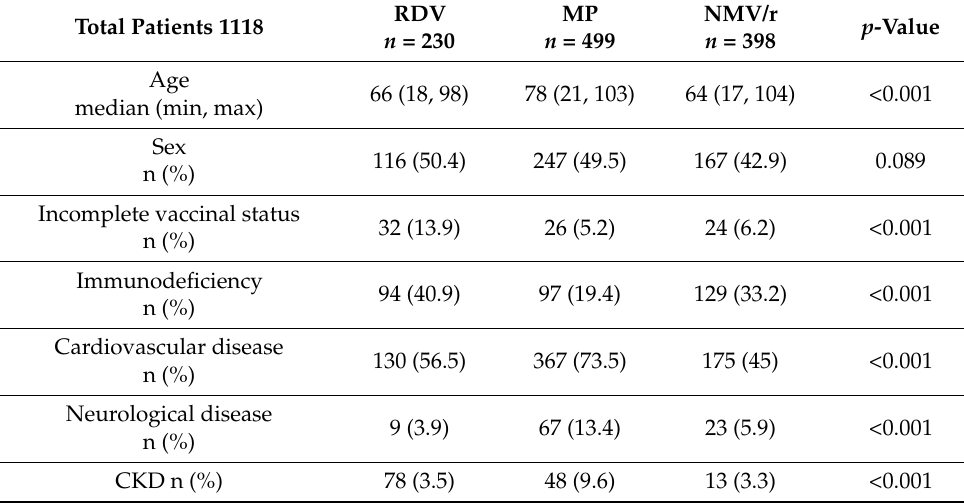
Table 1. Univariable analysis of demographic and clinical data of patients. MP: molnupiravir; RDV: remdesivir; NMV/r: nirmatrelvir/ritonavir; CKD: chronic kidney